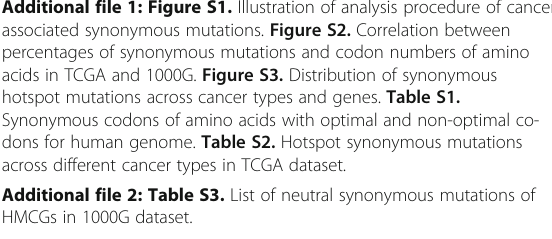
Additional file 1: Figure S1. Illustration of analysis procedure of cancer associated synonymous mutations. Figure S2. Correlation between percentages of synonymous mutations and codon numbers of amino acids in TCGA and 1000G. Figure S3. Distribution of synonymous hotspot mutations across cancer types and genes. Table S1. Synonymous codons of amino acids with optimal and non-optimal co- dons for human genome. Table S2. Hotspot synonymous mutations across different cancer types in TCGA dataset. Additional file 2: Table S3. List of neutral synonymous mutations of HMCGs in 1000G dataset. Additional file 3: Table S4. List of non-hotspot synonymous mutations of HMCGs in TCAGA dataset. Abbreviations 1000G: 1000 Genomes Project; ATts: AT transition; ATtv: AT transversion; BRCA: Breast cancer; C_GCts: CpG-island GC transition; C_GCtv: